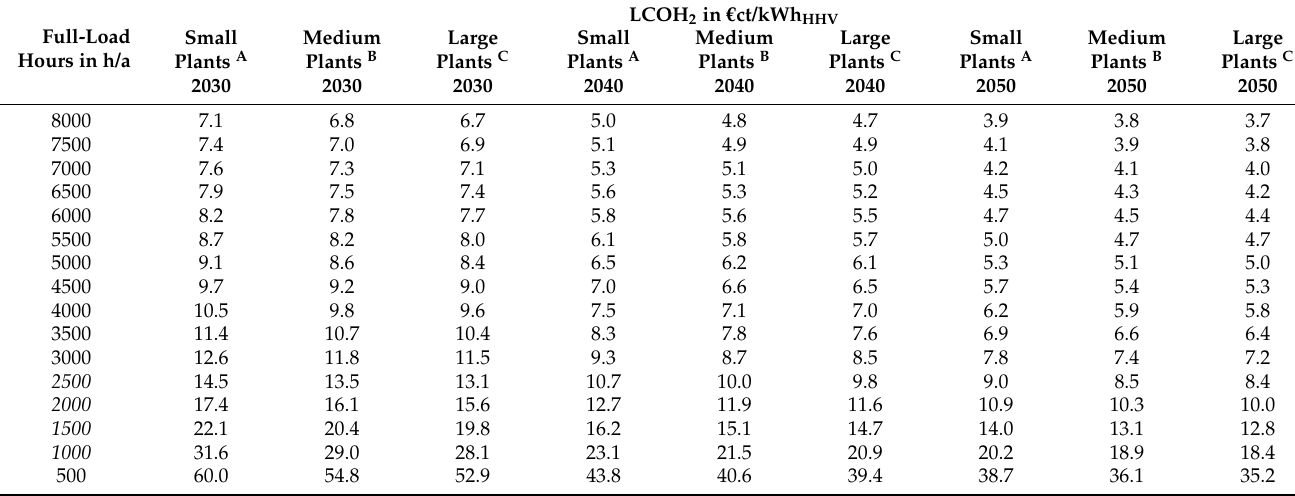
Table 4. LCOH 2 as a function of electrolysis size and number of full-load hours for the years 2030, 2040 and 2050. LCOH 2 is derived from cost structures represented in Table